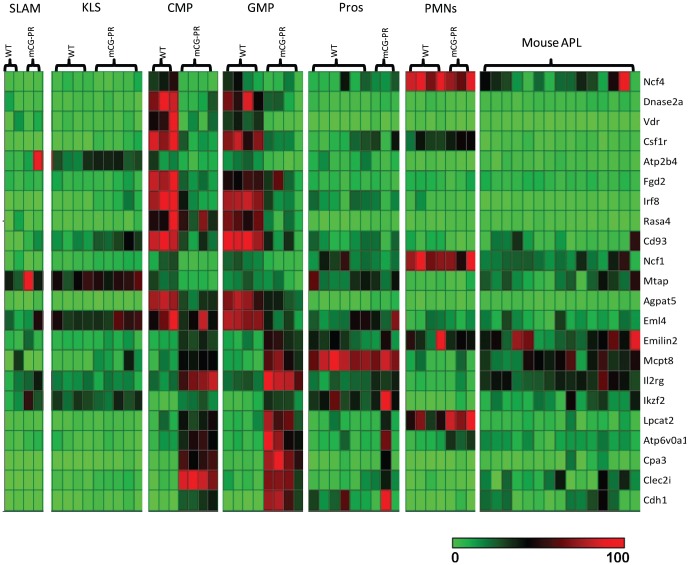
A supervised heatmap of the 22 genes significantly dysregulated in both the CMP and GMP compartments.We created a supervised clustering using SPOTFIRE of the 22 genes that were significantly dysregulated (unadjusted p value<0.001, fold change ≥2) in both the CMP and GMP ANOVA results comparing WT vs. Ctsg-PML-RARA samples. The supervised heatmap was created by plotting the relative expression of each of these genes to each other as a relative percentage, rather than z-score averaging, since the differences in expression levels between some genes was large, and z-score averaging inappropriately highlighted the genes with the highest expression levels. The legend is shown below the heatmap, with minimally expressed genes in green, and highly expressed genes in red.